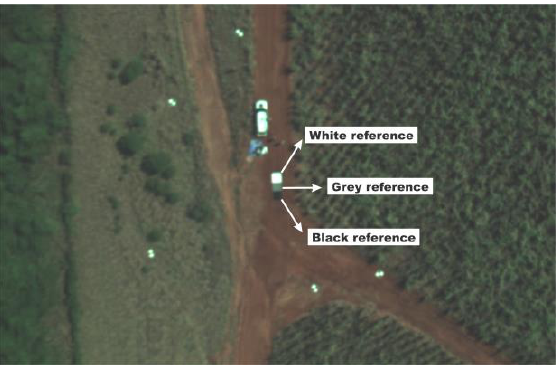
Table 2. Average number of pixels per tree species, number of trees recognized in field and used for the training set and, number of pixels used as training set